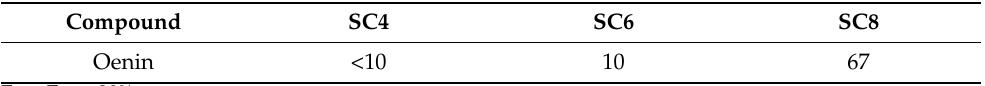
Table 2. Association constants K CBˆSCn (M − 1 ) for the formation of 1:1 host-guest complexes between p -sulfonated calix[n]arenes and the CBˆ species of Oenin. K CBˆSCn (M − 1 ) calculated after fitting (Equation (2)) of the data obtained after titration of Oenin (2.0 × 10 − 5 M; 1.8 × 10 − 5 M; 1.8 × 10 − 5 M) solutions with increasing concentrations of SC4, SC6 and SC8 at pH ≈ 3.5.